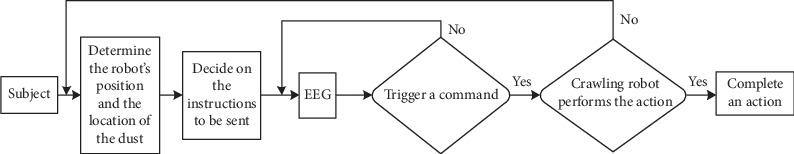
Flowchart of the subject performing a brain control task.